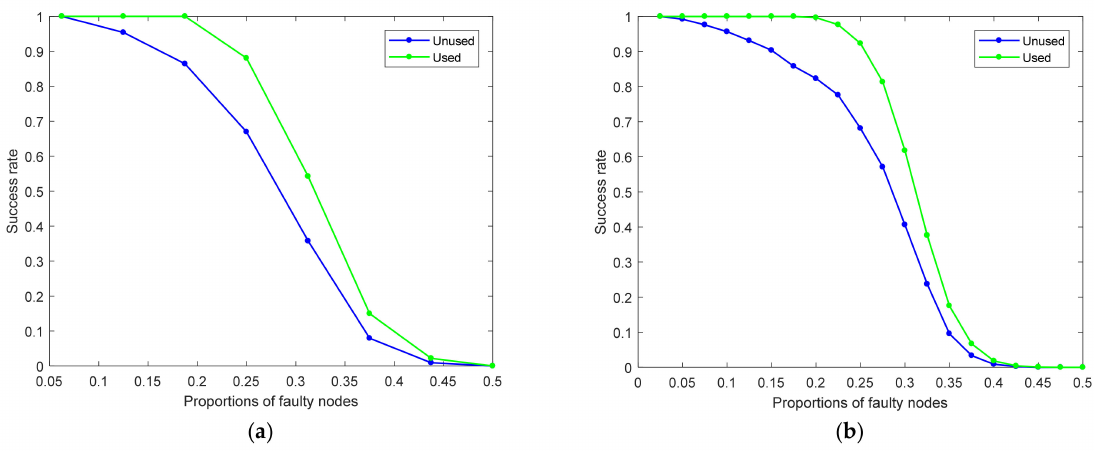
Figure 8. The influence of comprehensive evaluation model on TB-PBFT algorithm, ( a ) m = 4, n = 16, ( b ) m = 10, n =